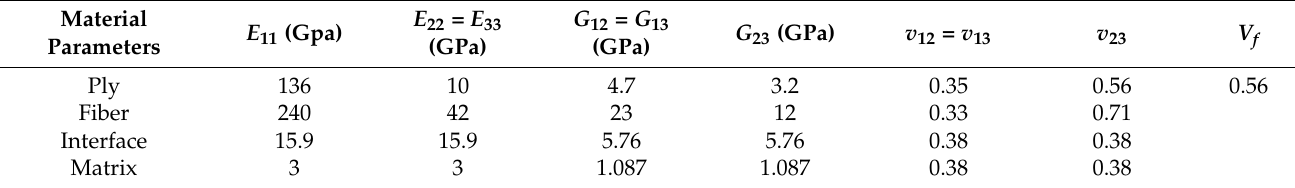
Table 1. Elastic parameters for the composites and constituents [14,16].